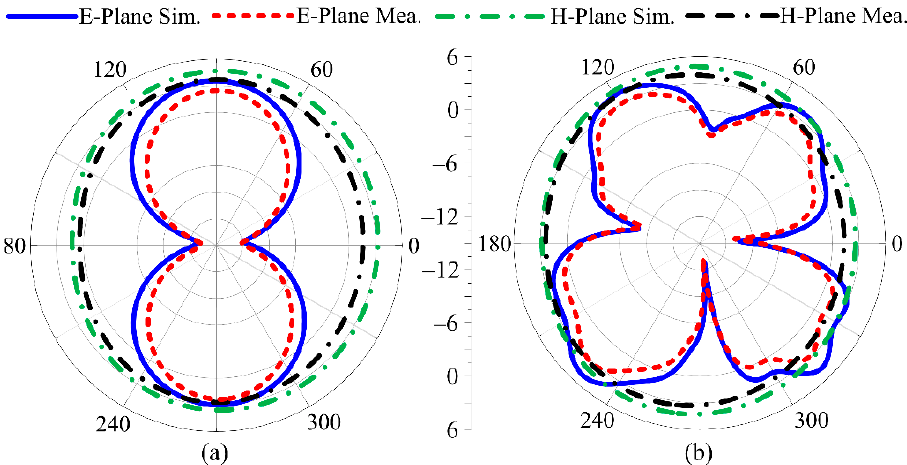
Figure 12. Predicted and measured radiation pattern of suggested UWB antenna without FSS at ( a ) 8 GHz; ( b ) 13 GHz.